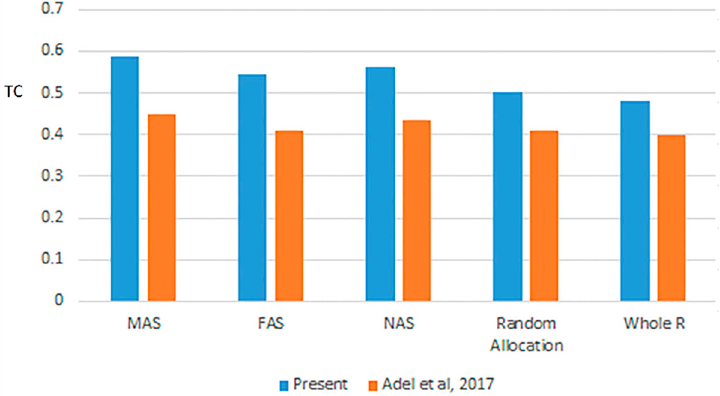
Figure 10. TC for the five problems, with all scenarios of the works under comparison.